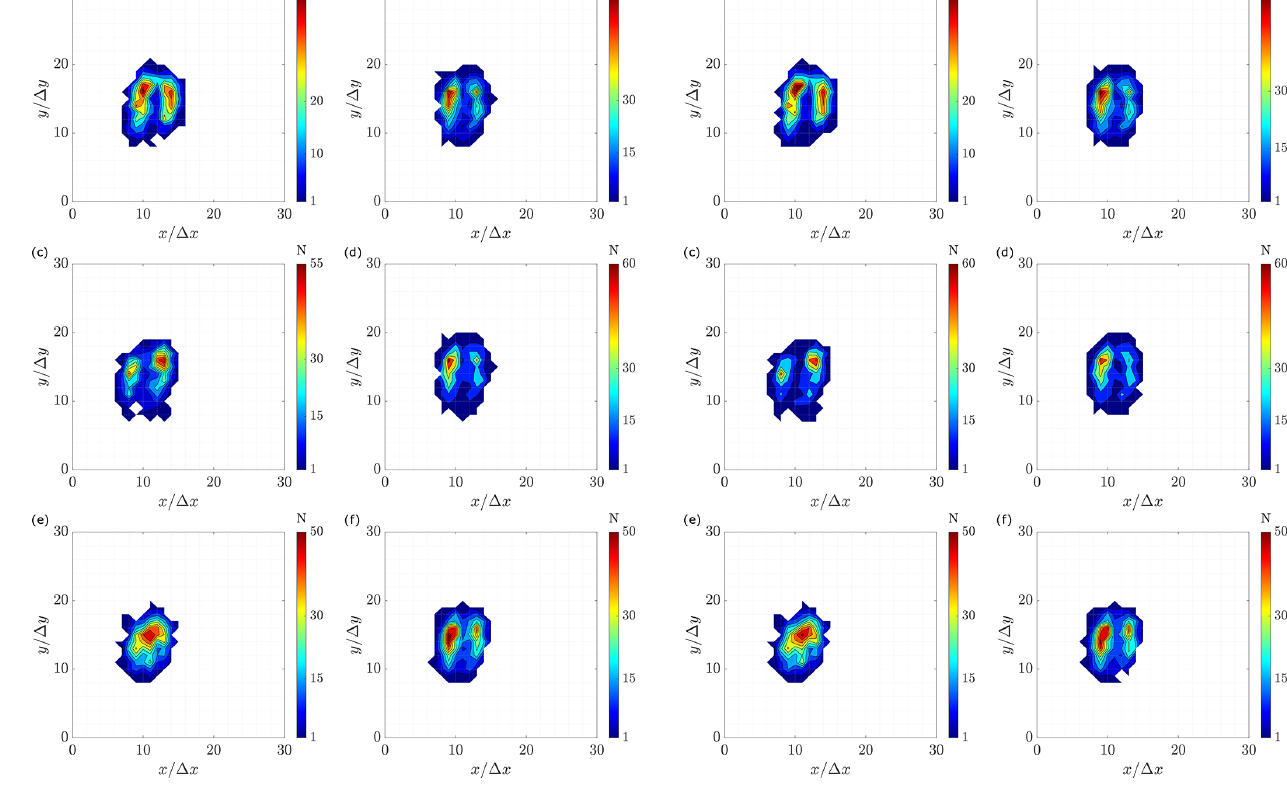
Figure A3. Vorticity probability contours. (a) Backward difference. (b) Central difference. (c) Forward difference. (d) Richardson ex- trapolation. (e) Least squares. (f) Circulation method.